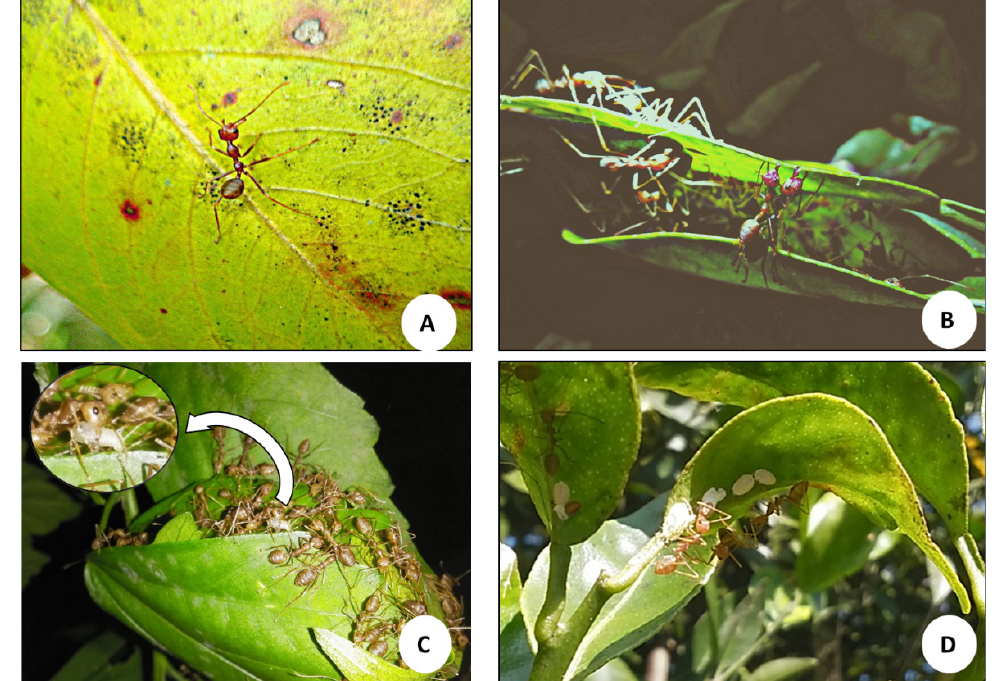
Fig 7 . Representative photographs of worker ants and nest construction by O. smaragdina in needlewood tree. (A) Individual worker ant, (B) Worker ants pulling the leaves together, (C) worker ants squeezing the larva during nest construction, and (D) weaver ants tending the scale insects